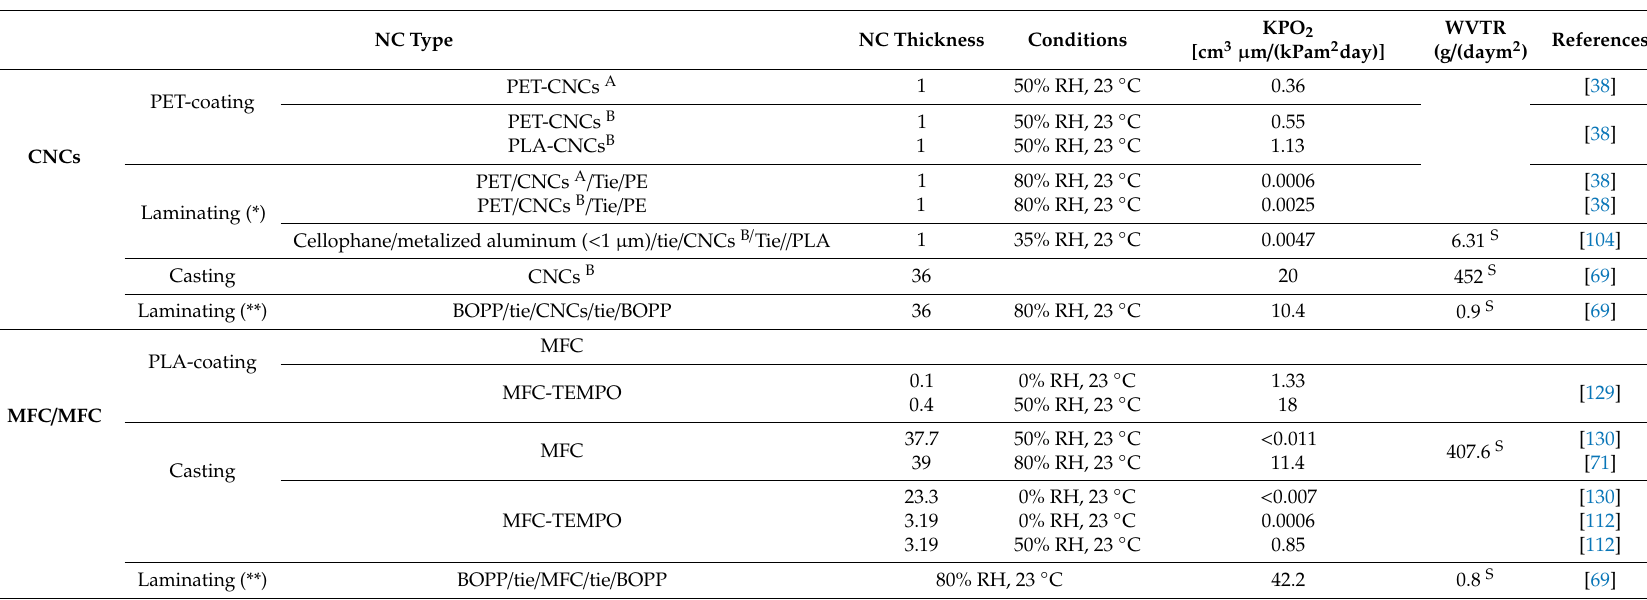
Table 6. Coated nanocellulose (NC) and laminated (*), casted NC and laminated (**); cellulose nanocrystals-ammonium persulfate (CNCs-APS) ( A ); CNCs-H 2 SO 4 ( B ); 90% RH and 38 ◦ C ( S